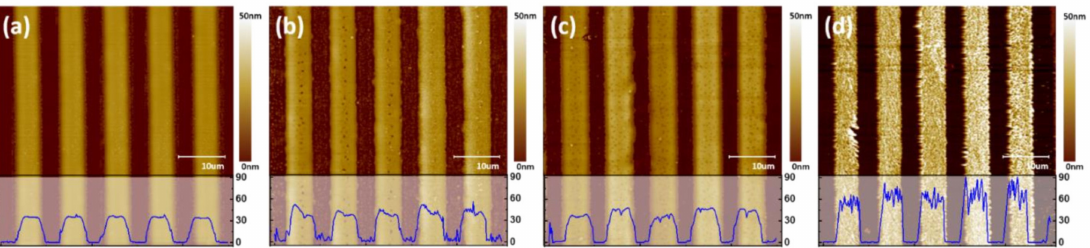
Figure 7. AFM images of sublimation transferred patterns after the drying process ( a ) at room temperature, ( b ) 30 ◦ C, ( c ) 50 ◦ C, and ( d ) 80 ◦ C in a vacuum chamber. Insets are cross-sectional data,